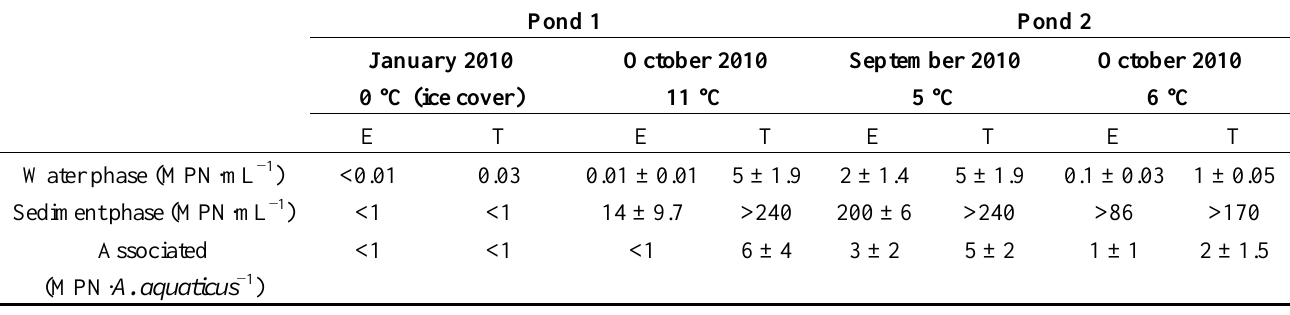
Table 1. Concentrations of E. coli and total coliform bacteria in water, sediment and associated with A. aquaticus from two surface water